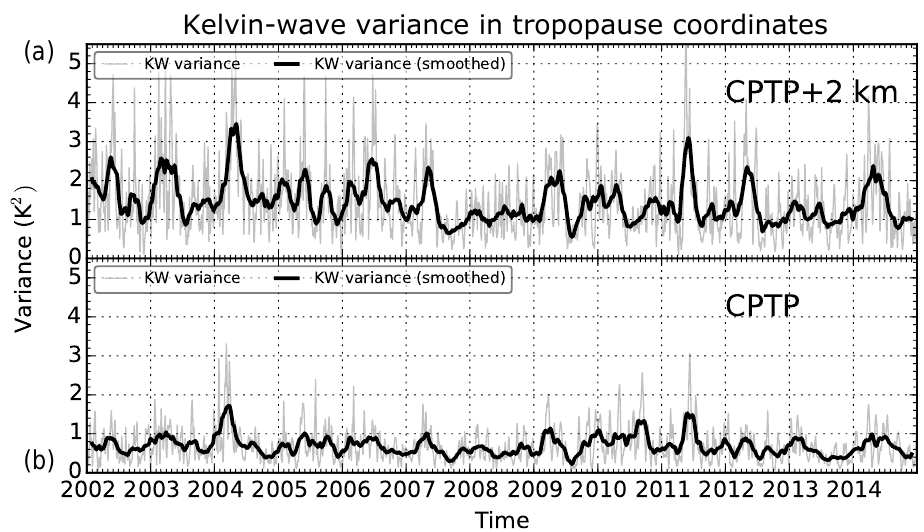
Figure 9. Time series of daily Kelvin-wave variance (thin gray) and smoothed Kelvin-wave variance (thick black) from January 2002 to December 2014 at the cold-point tropopause (bottom) and 2km above (top).